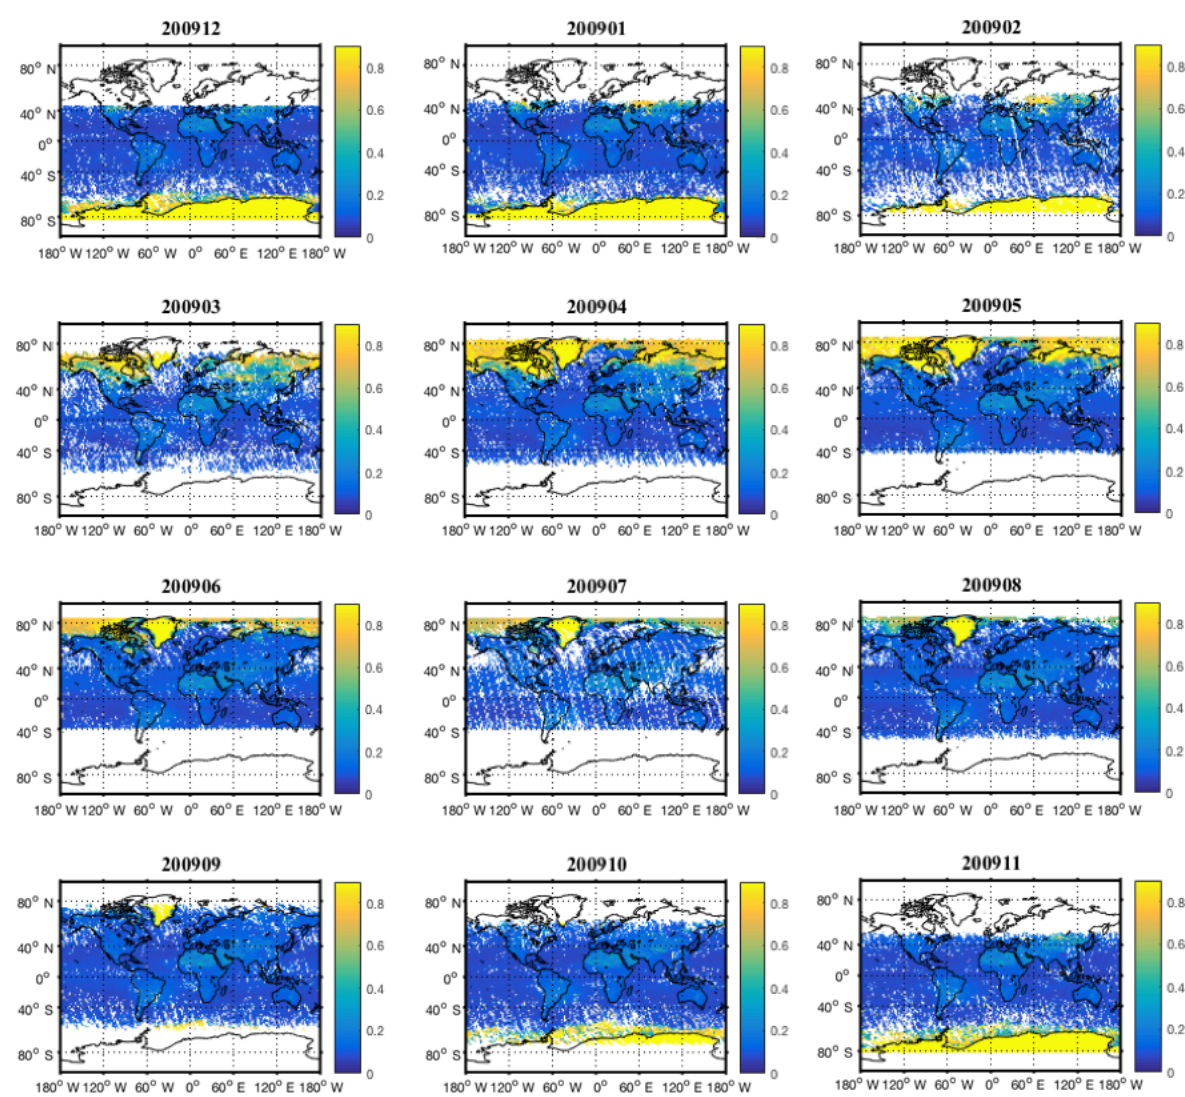
Figure 15. The monthly CALIOP column reflectance for clear sky condition in 2009. The areas of white are where there are insufficient observations to derive a meaningful